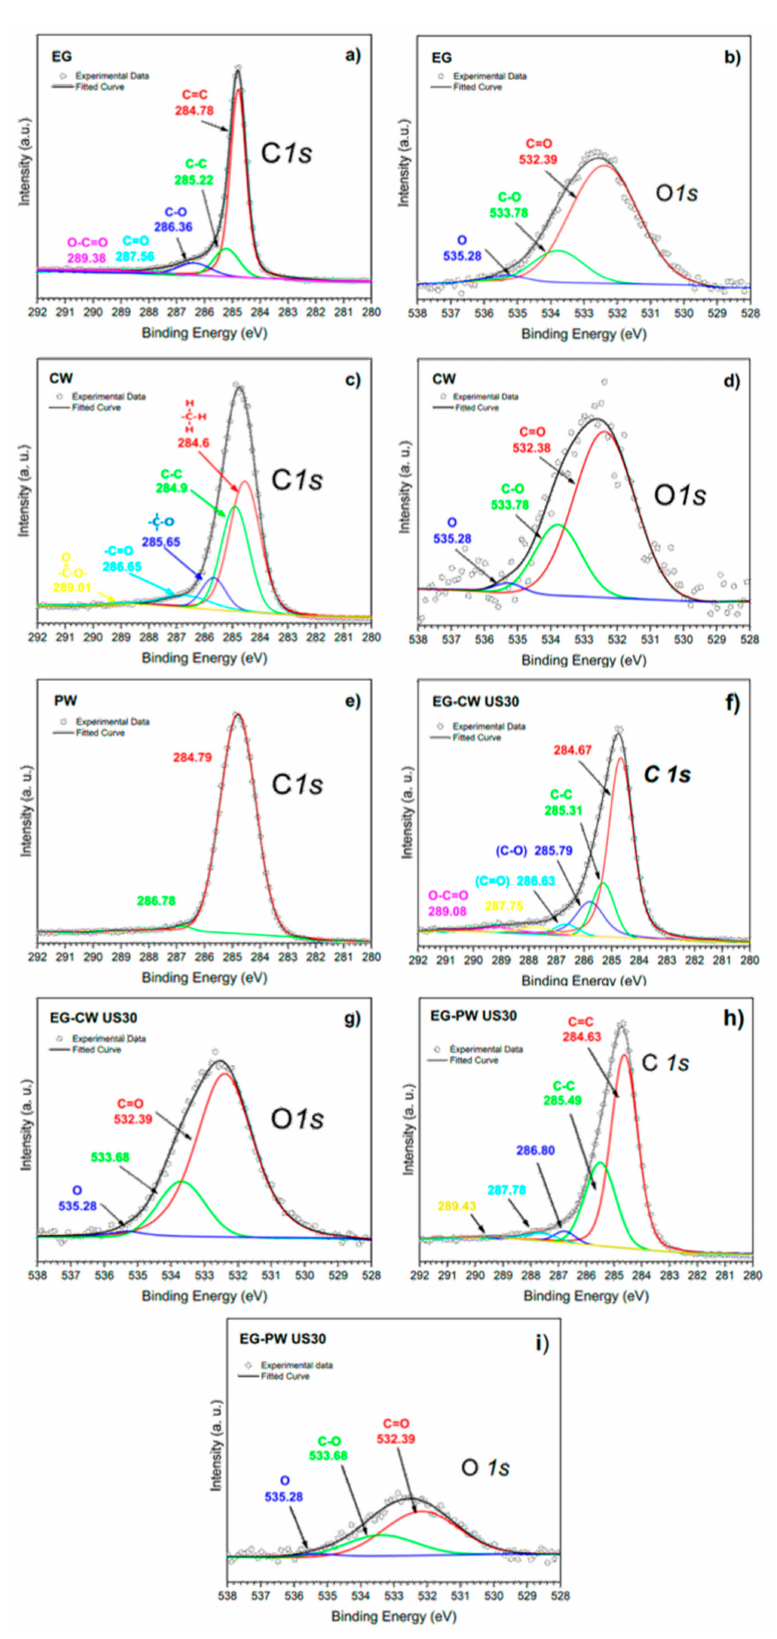
Figure 13. X-ray photoelectron spectra of wax matrices and expanded graphite extracted from ultrasound-treated wax composites. ( a , b ) Pristine EG. ( c , d ) CW matrix, ( e ) PW matrix, ( f , g ) EG-CW ultrasound treated, and ( h , i ) EG-PW ultrasound